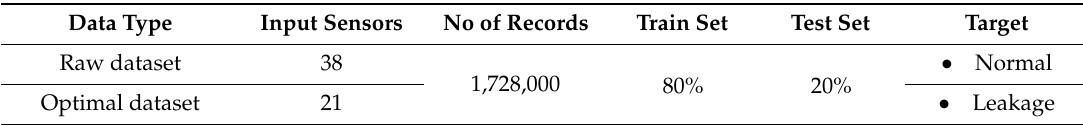
Table 4. Characteristics of the dataset used for machine learning.